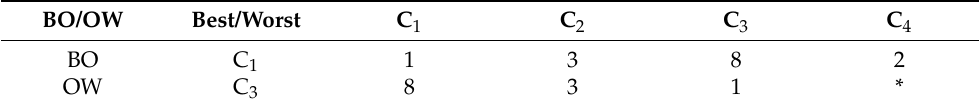
Table 3. The vectors of comparison results.